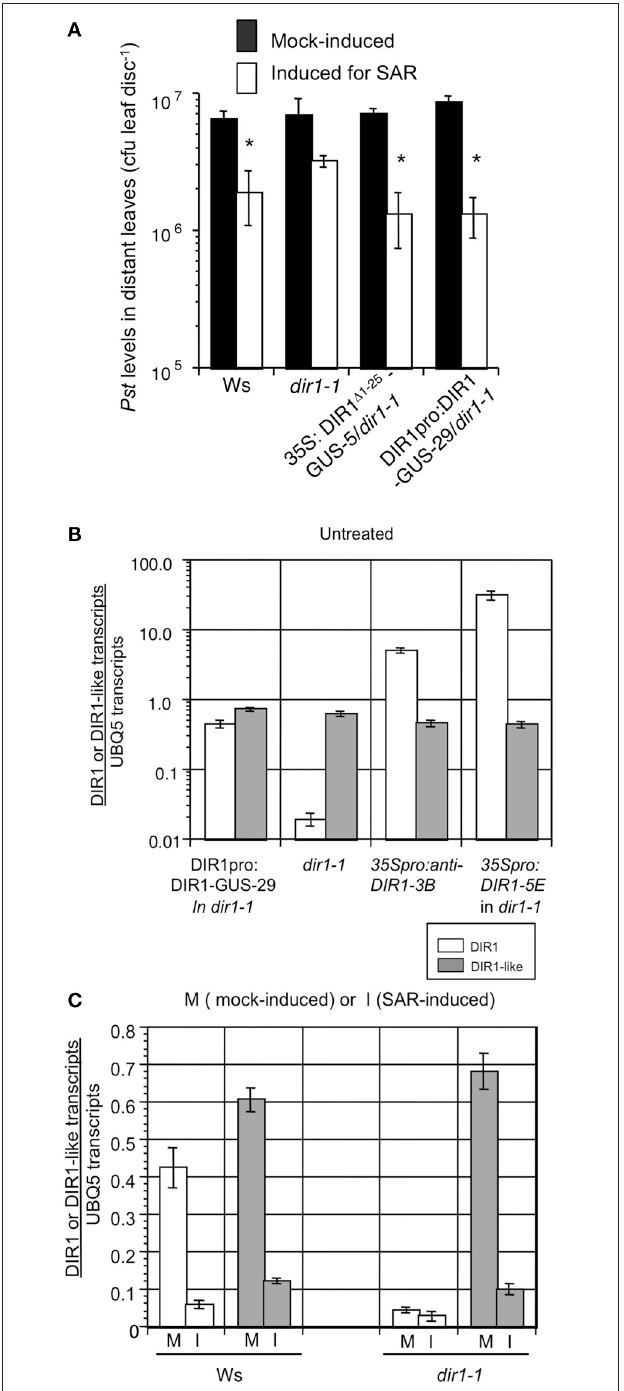
FIGURE 3 | A partial SAR response is sometimes observed in dir1-1. (A) SAR assays were conducted on Ws, dir1-1 , DIR1pro:DIR1-GUS-29/ dir1-1 and 35S: DIR1 (cid:2) 1 − 25 -GUS-5/ dir1-1 by inoculating with 10mM MgCl 2 (mock-induced) or inducing for SAR with Pst (avrRpt2) (SAR-induced) in 1–2 lower leaves, followed by challenge inoculation with virulent Pst in distant leaves 2 days later. Bacterial levels were determined in challenged leaves 3dpi. Asterisks ( ∗ ) denote a significant difference (student’s t -test, p < 0 . 05) in bacterial levels between challenged distant leaves of mock-